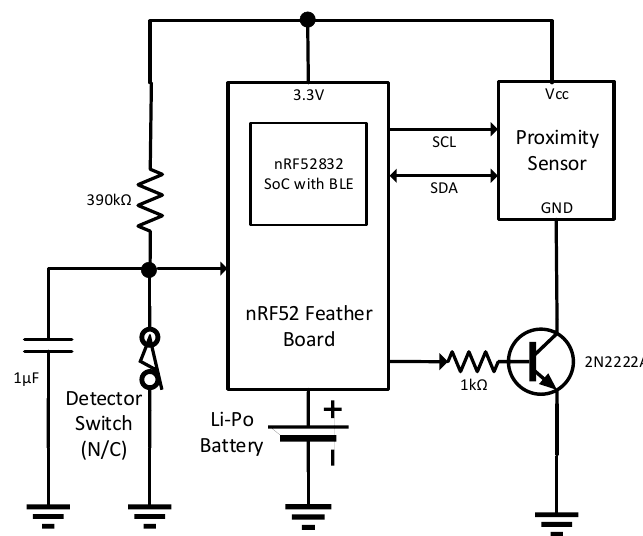
Figure 2. Block diagram of the hardware device that is attached at the bottom of the canister cap.